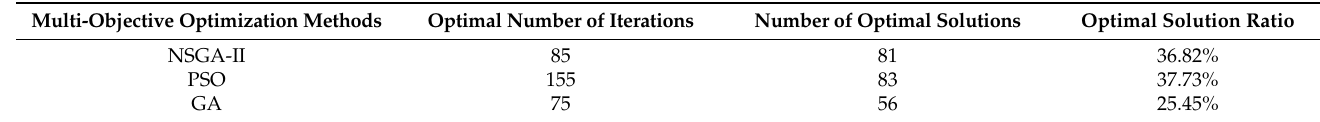
Table 3. Comparison of NSGA-II, PSO and